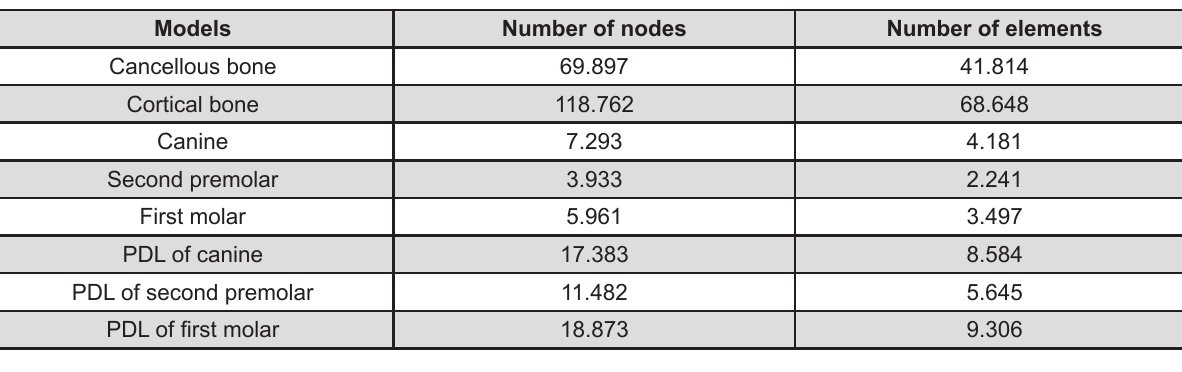
Figure 2- Number of nodes and elements generated for initial model PDL=periodontal ligament